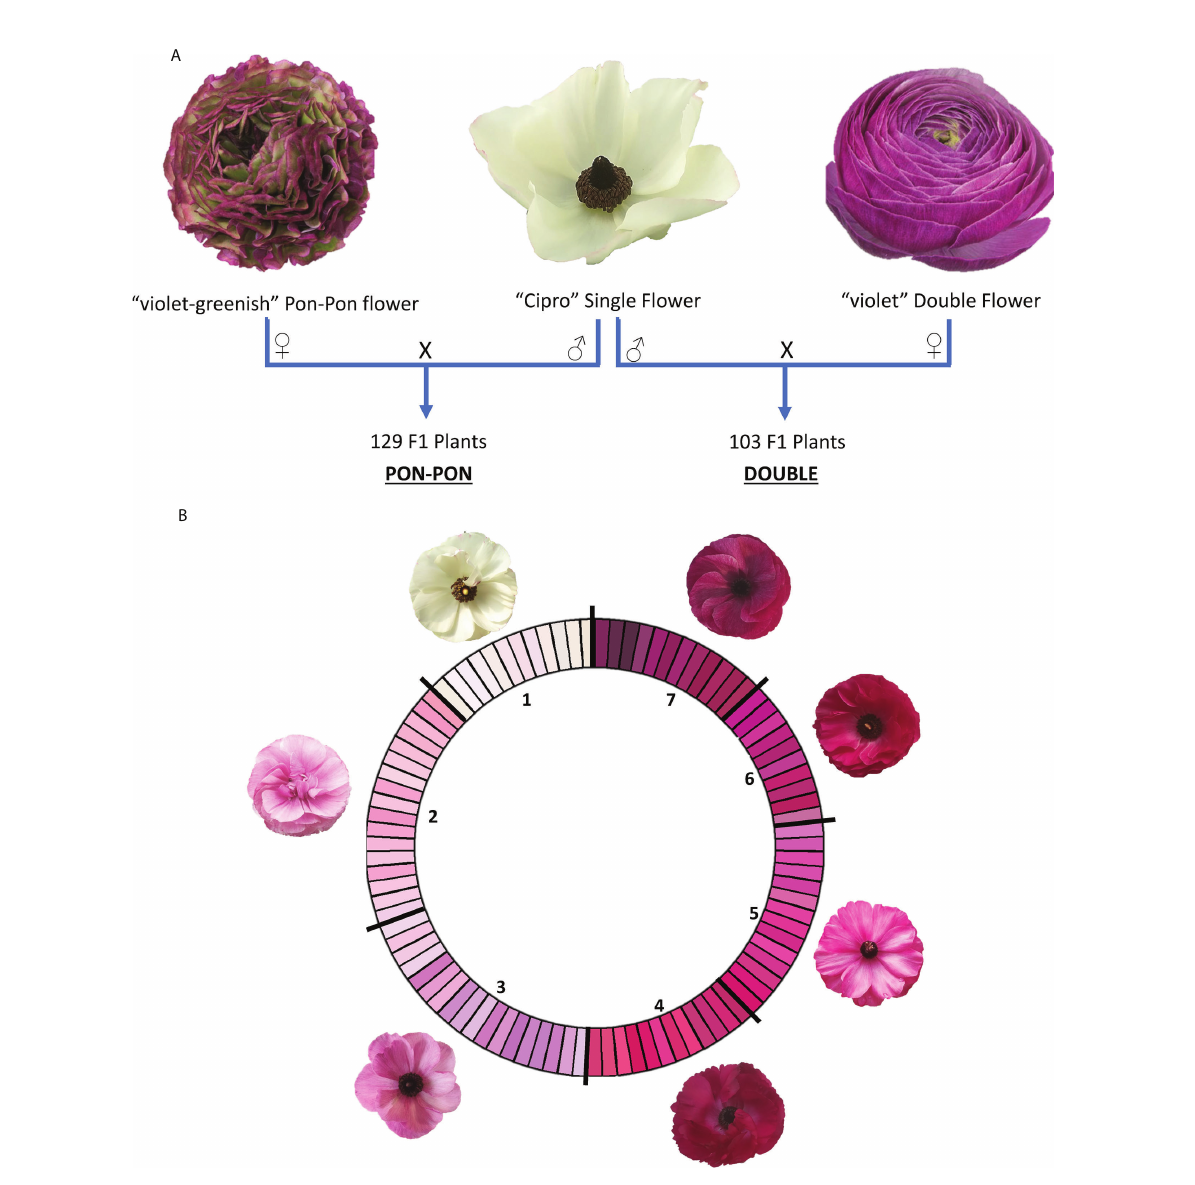
FIGURE 1 (A) Crossing scheme for the development of the two mapping populations (PON-PON and DOUBLE); (B) RHS-based color scale used for fl ower phenotyping. RHS classes were coded according to their intensity in 1-7 scale. 1: white; 2: light blue pink; 3: light violet; 4: medium purple red; 5: dark blue pink; 6: medium purple; 7: dark